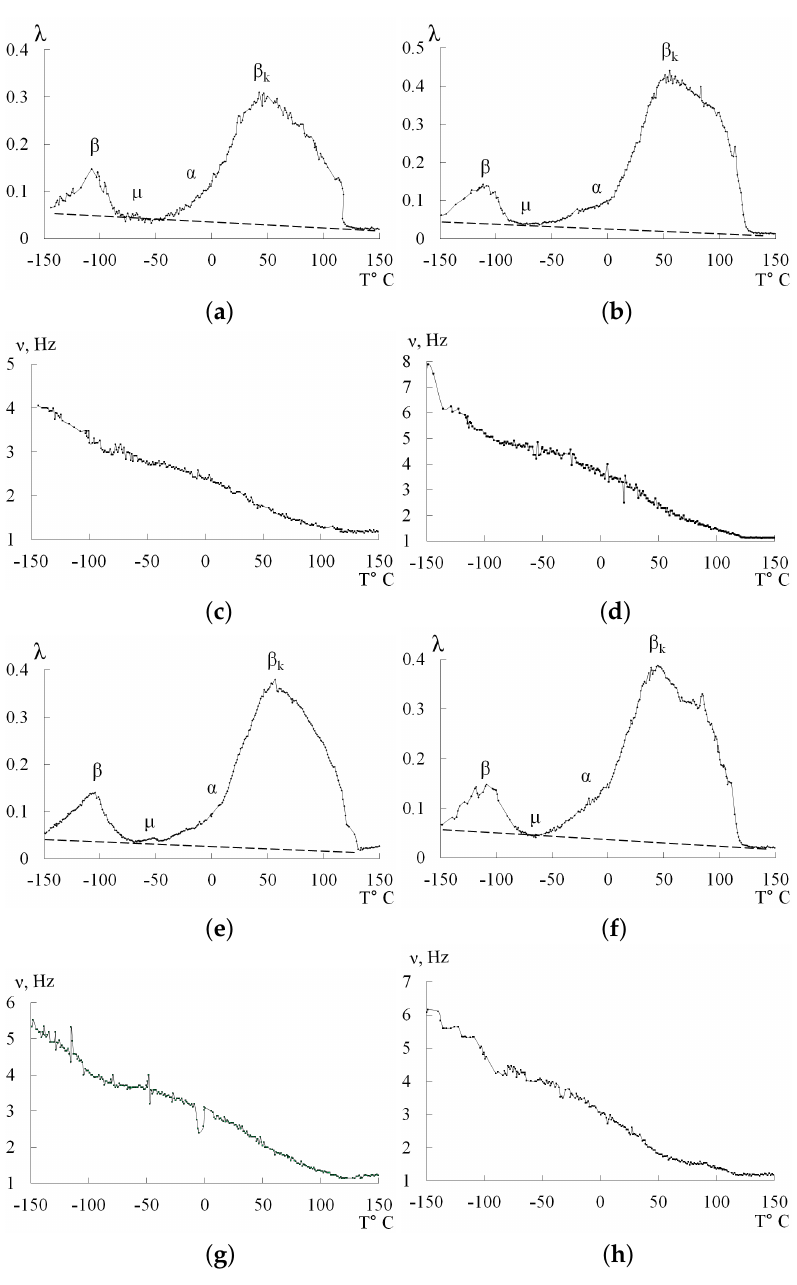
Figure 4. Internal friction λ = f ( T ) and temperature-dependent frequency spectrum ν = f ( T ) for HDPE 277-73 ( a , c ); HE3490-IM ( b , d ); CRP100 Hostalen ( e , g ); Stavrolen PE4PP-25B ( f , h